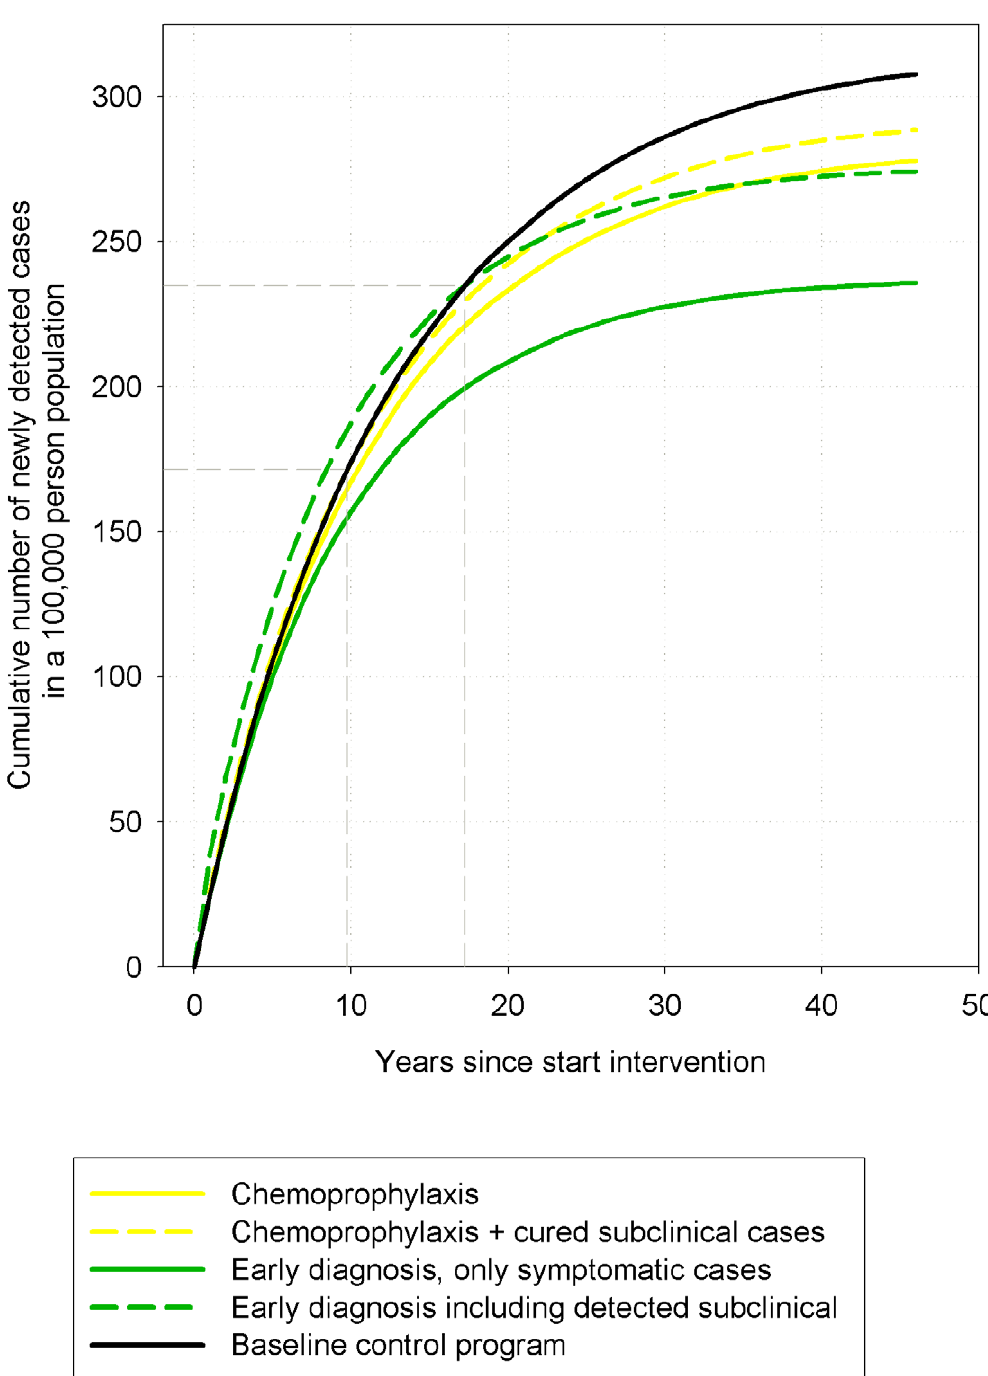
Figure 3. Cumulative New cases detected of leprosy per person-year since start of the interventions. Results are the average of 100 runs of the simulation model.